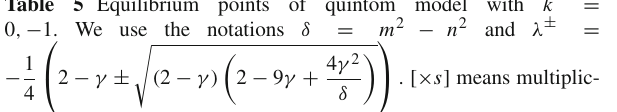
Table 5 Equilibrium points of quintom model with